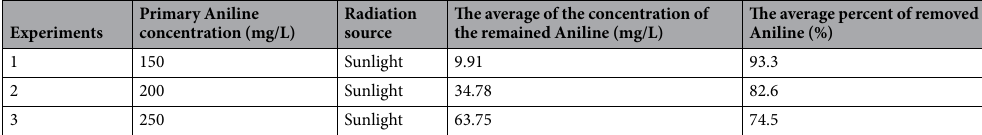
The average of the concentration of the remained Aniline (mg/L)